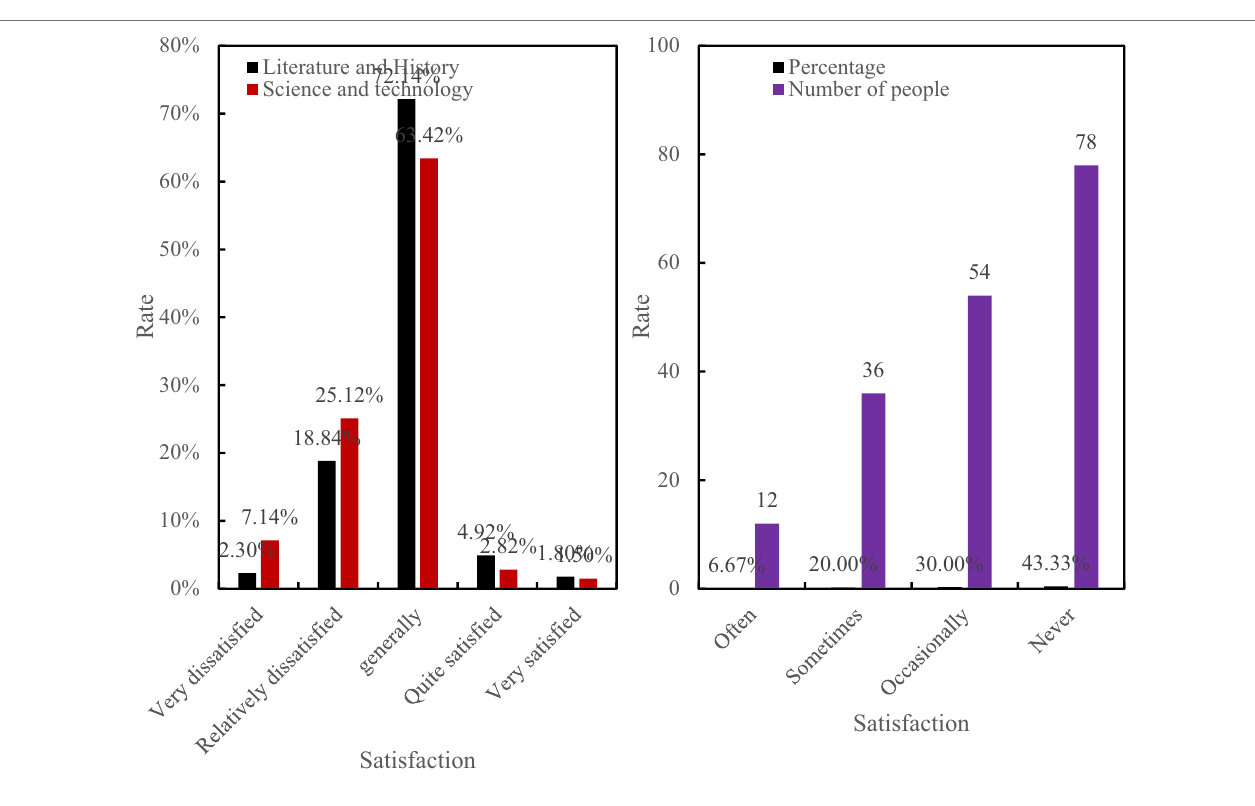
FIGURE 5 | Students’ overall satisfaction and enthusiasm for teaching psychology management.